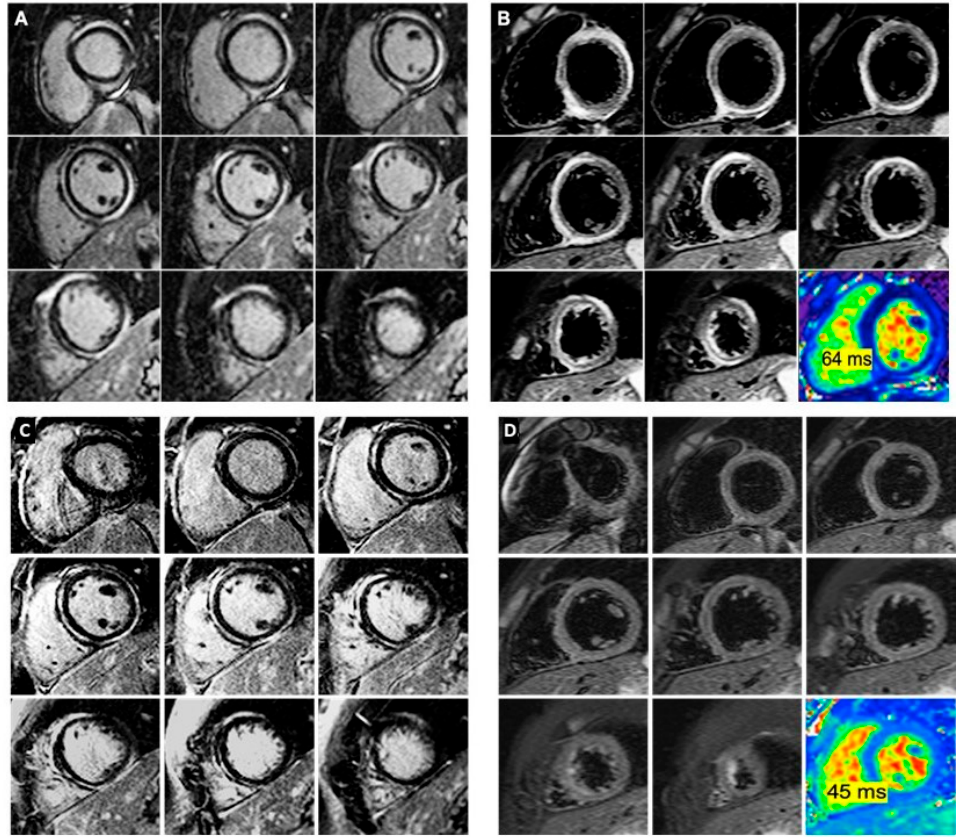
Figure 2. Contrast enhanced cardiac magnetic resonance during the chest pain episode (panels ( A , B )) and at the 5-month follow-up (panels ( C , D )). ( A ) Late gadolinium enhancement (LGE) imaging shows circumferential, subepicardial ring-like scarring of the left ventricle walls extending from the base to the apex. ( B ) Corresponding T2-weighted images showing areas of high T2 signal suggestive of myocardial oedema with similar topography to the scar. The corresponding short axis T2 map is displayed, showing increased T2 time of 64 ms. ( C ) Late gadolinium enhancement (LGE) imaging shows circumferential, subepicardial ring-like scarring of the left ventricle walls with the same extension as in the initial exam. ( D ) Corresponding T2-weighted images showing homogenous T2 signal, suggesting the absence of myocardial oedema. The corresponding short axis T2 map is displayed, showing normal T2 time of 45 ms.